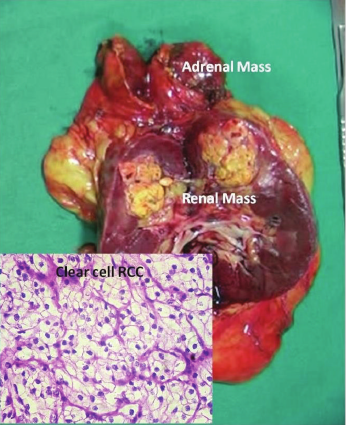
Figure 1: CECT scan showing right renal and adrenal tumors.